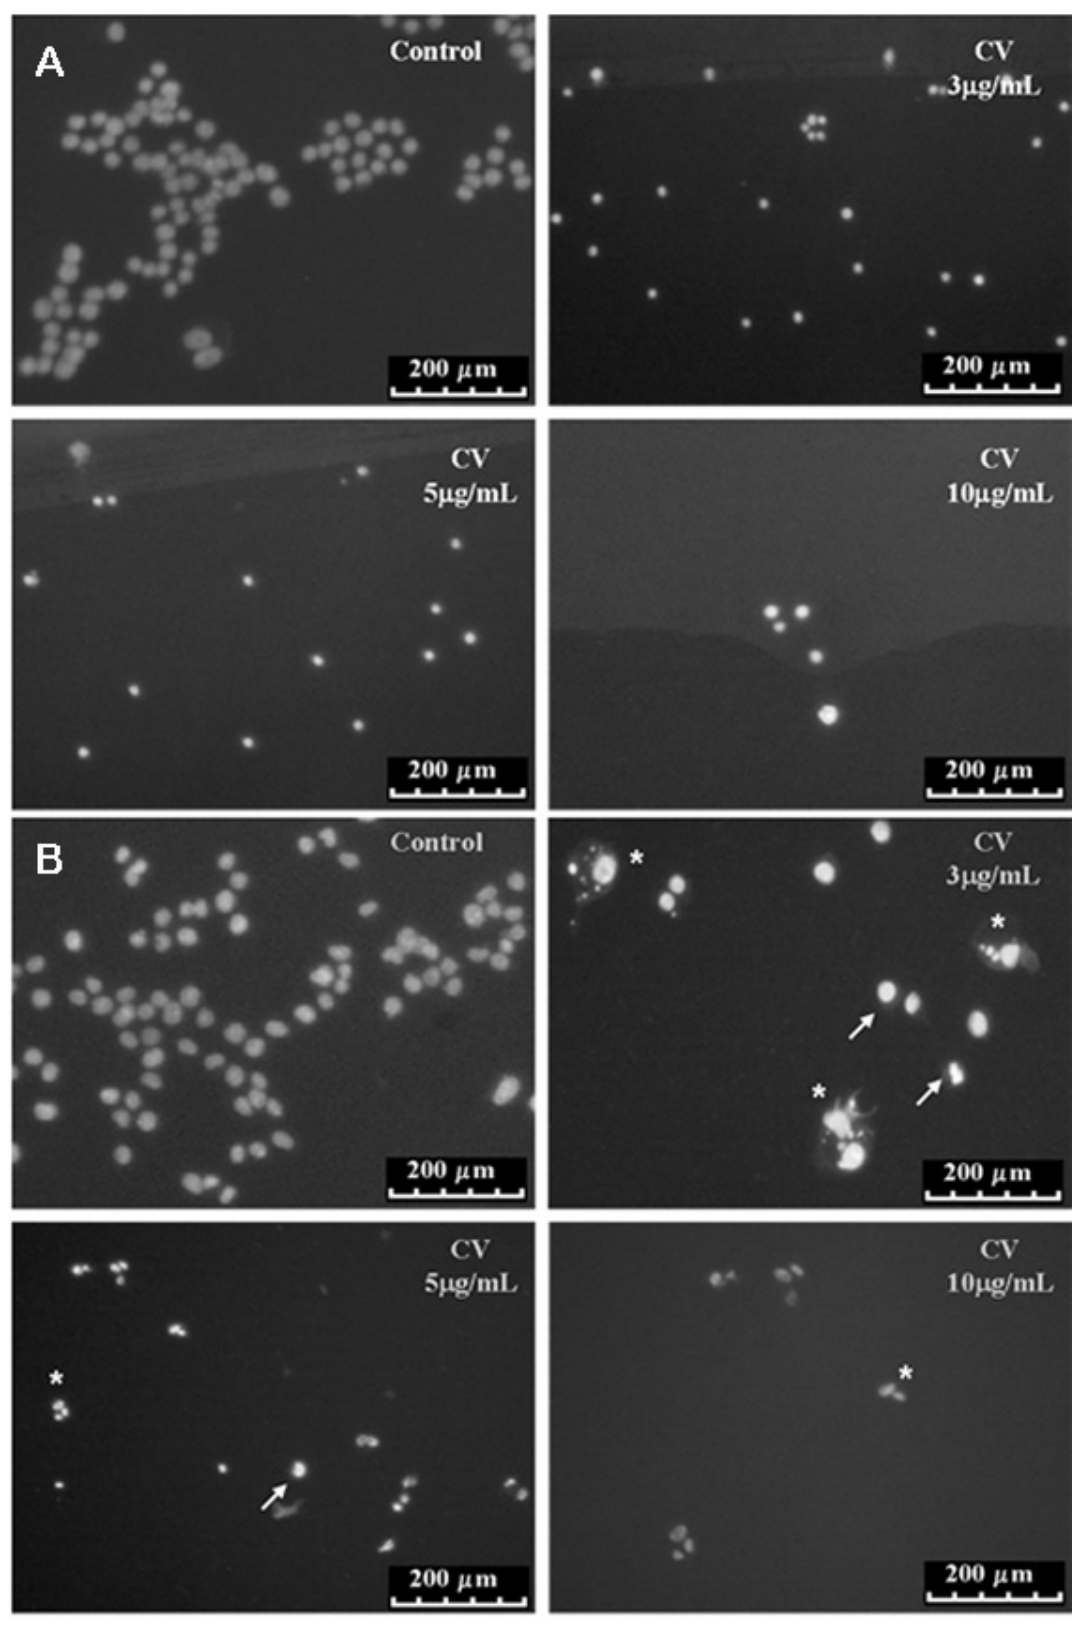
Figure 3. Cell death induced by CV: ( A ) GH3 cells and ( B ) RT2 cells. Brain tumor cells were treated with different CV concentrations for 48 hours. After the treatment the cells were stained with DAPI stain. Nuclear condensation (indicated by arrows) and apoptotic body formation (indicated by asterisks) were seen in the CV-treated